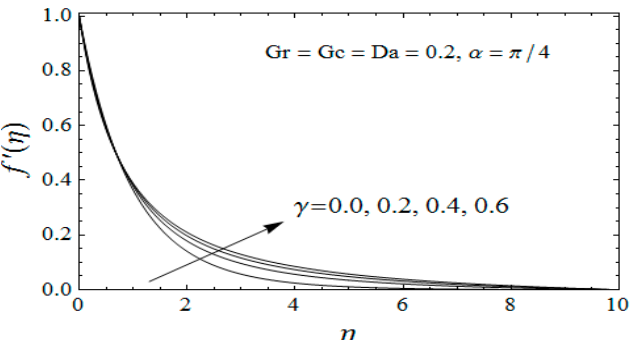
Figure 3. 𝑓′(𝜂) for different 𝐷𝑎.